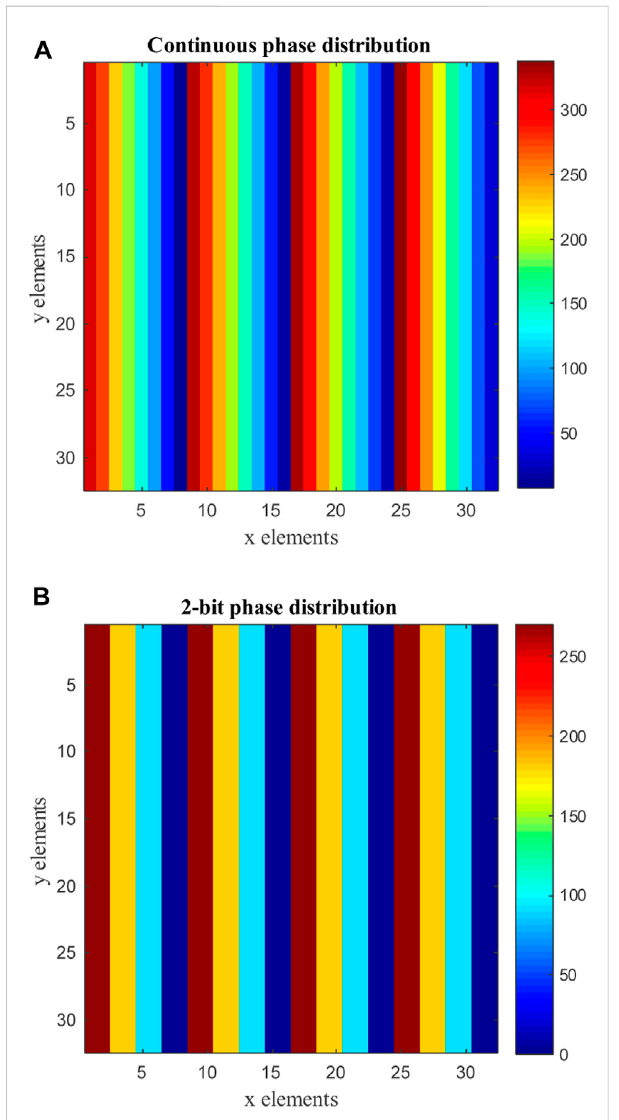
FIGURE 7 RIS phase distribution for beam steering at 30 ° . (A) Continuous phase. (B) 2-bit quantization.